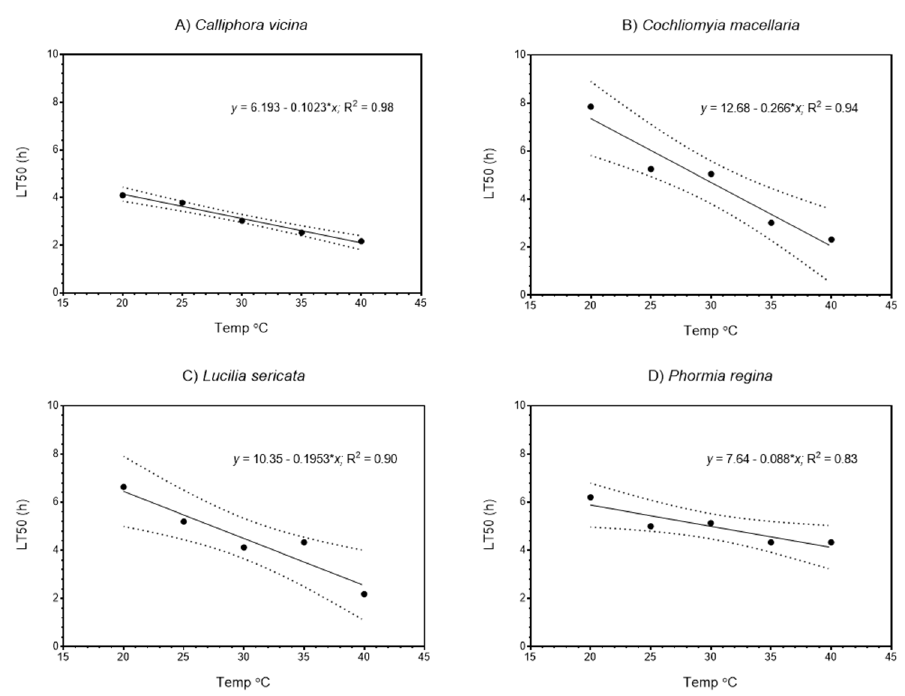
Figure 1. Relationships between LT50 (lethal time to 50% survivorship) and temperature (°C) for four species of blow fly: ( A ) Calliphora vicina , ( B ) Cochliomyia macelleria , ( C ) Lucilia sericata , and ( D ) Phormia regina . Dotted lines indicate 95% confidence limits.